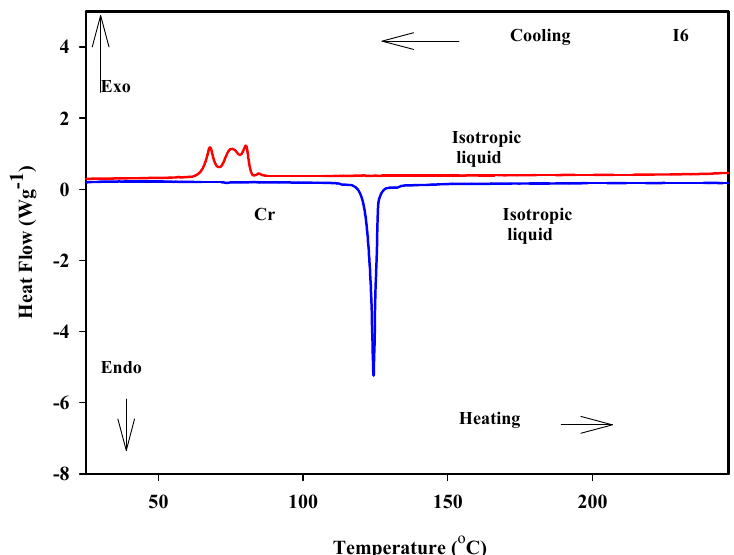
Cr-I = solid to the isotropic liquid phase transition. Figure 2. DSC thermogram of sample I 6 on heating/ cooling cycles with rate 10 °C min − 1 . Table 1. DSC transition temperatures (°C) and enthalpy of transition Δ H , kJ/mole for series I n .